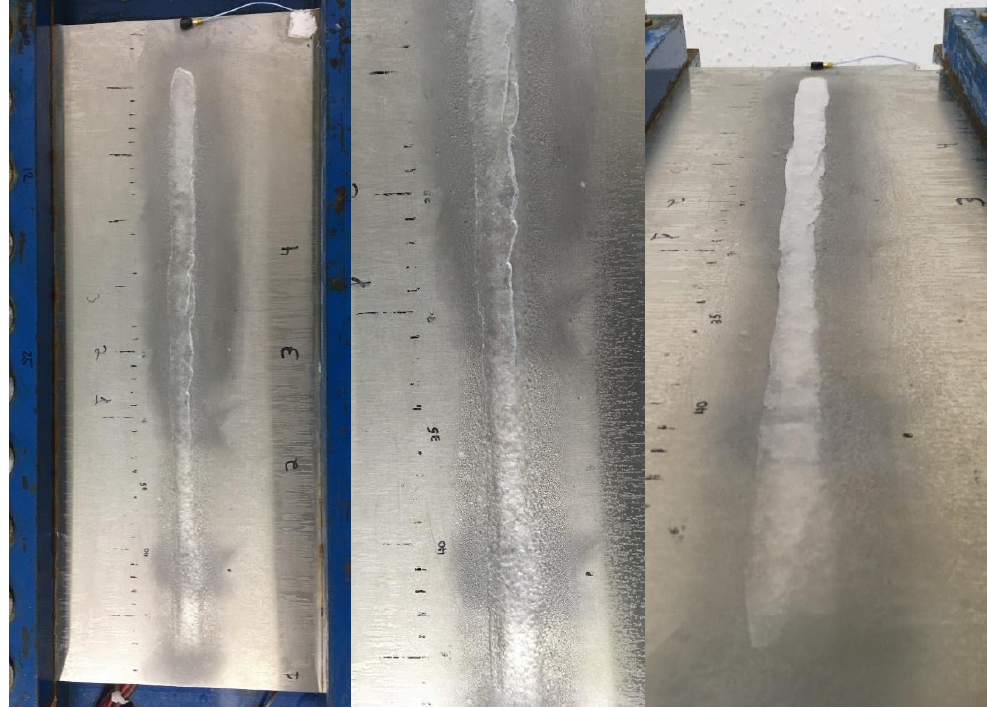
Figure 16. Delamination of the ice at 575 Vpp in steady-state activation with all piezoelectric actuators activated in phase at 183 Hz.